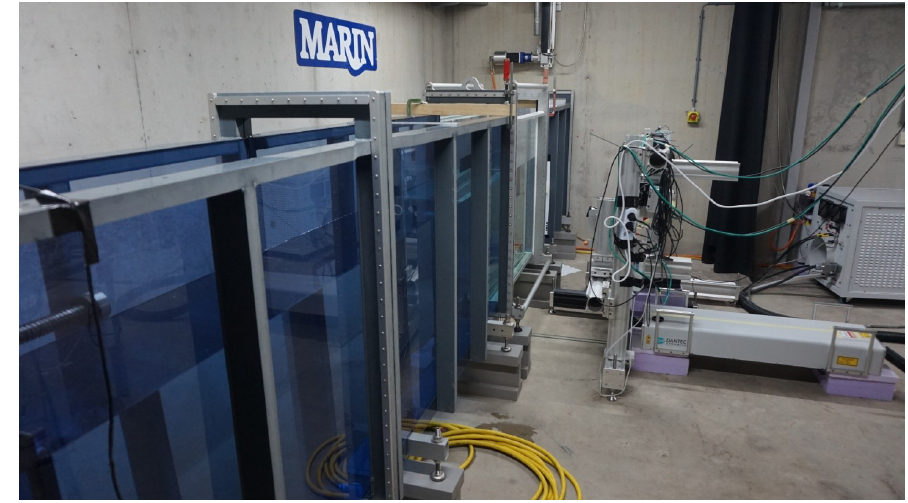
Figure 13. MARIN Research Flume with a breaking wave